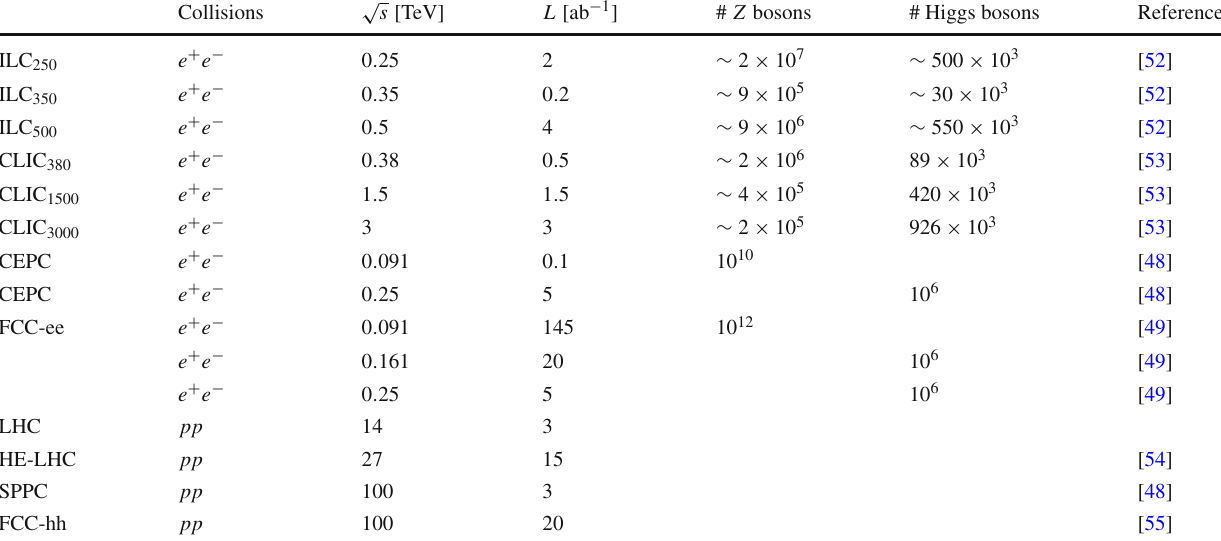
Table 1 Benchmark specifications of various future collider proposals. The number of Z and Higgs bosons indicated with a ∼ have been